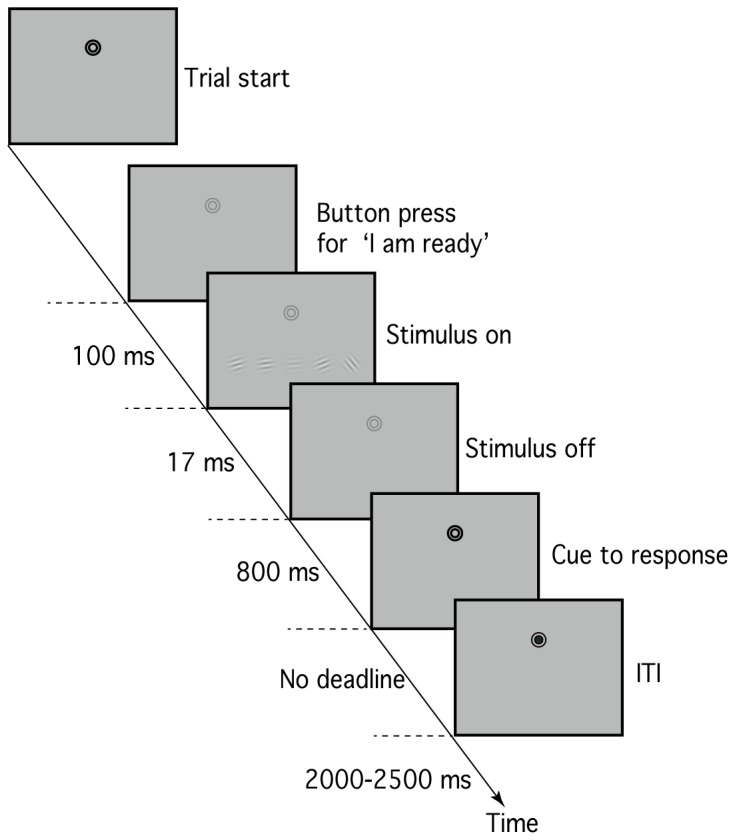
Trial sequence for the observer-control condition.Participants were asked to monitor their internal status and, when they judged their attention to be maximal, depress a button to initiate presenting stimuli. The passive viewing condition followed the same procedure except that the time before the stimulus onset was controlled by a computer selecting from the recorded latencies in the previous block of the observer control condition.